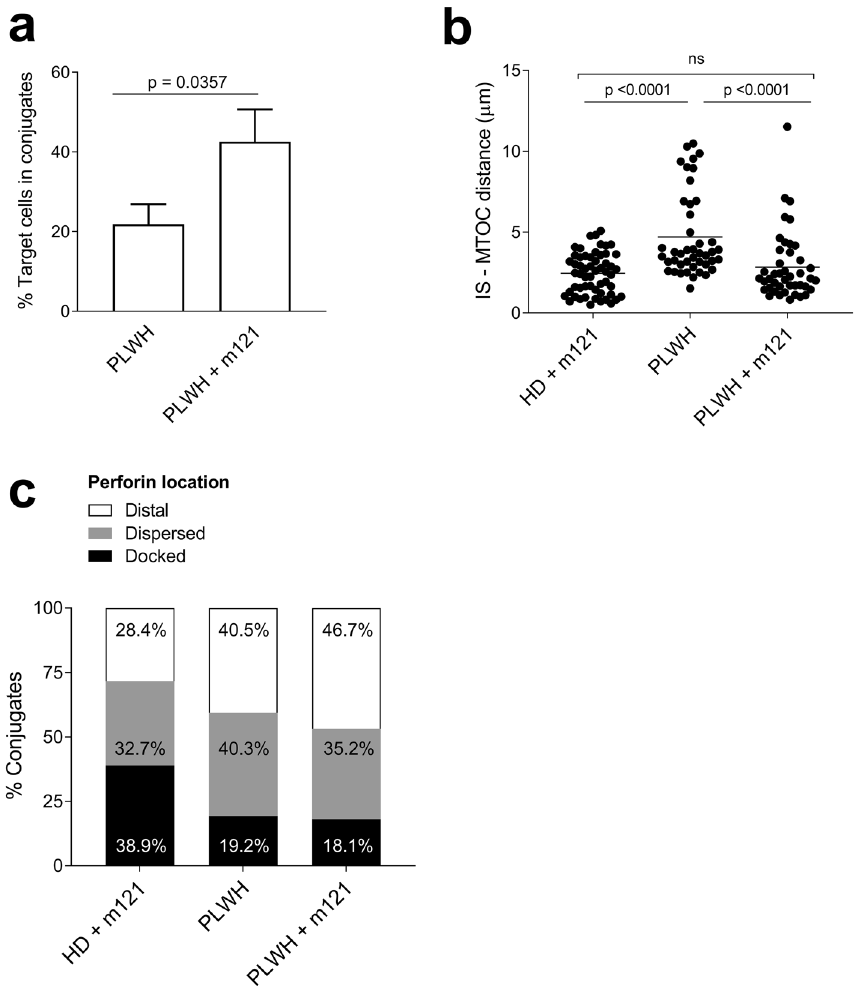
Figure 3. Comparison of ImmTAV-mediated immunological synapses formed by CD8 + T cells from HIV-naïve subjects and PLWH. SL9-pulsed T2 cells were cultured with HIV-naïve donor (HD) CD8 + T cells (n = 3) or SL9 peptide pre-stimulated PLWH CD8 + T cells (n = 3) at a ratio of 1:1 in the presence or absence of m121 ImmTAV (0.5 nM). ( a ) Quantification of conjugates formed after 15 min with pre-stimulated PLWH ± ImmTAV (n > 50 targets counted/slide, blinded analysis) and plotted as mean ± SD). ( b ) Quantification of MTOC distance from the IS (µM; data were analysed by one-way ANOVA with correction for multiple comparisons) and ( c ) % conjugates with distal, dispersed or docked expression of perforin in HD and PLWH CD8 + T cells. At least 10 conjugates per subject and per condition were analysed and data were